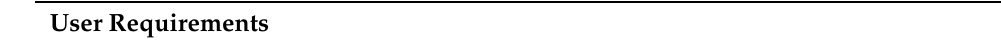
Table 2. User Requirements.